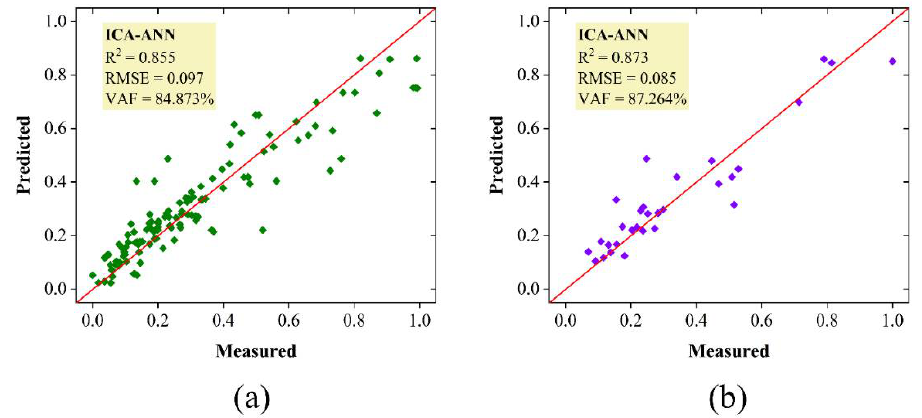
Figure 15. The results bearing capacity of the SCFST columns by ICA-ANN; ( a ) training, ( b ) test- ing.